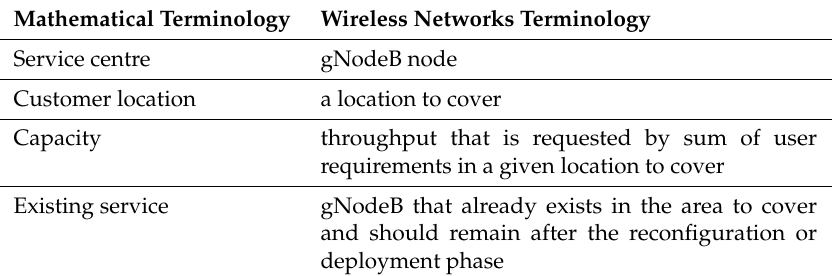
Table 1. Mapping mathematical terminology to communication networks